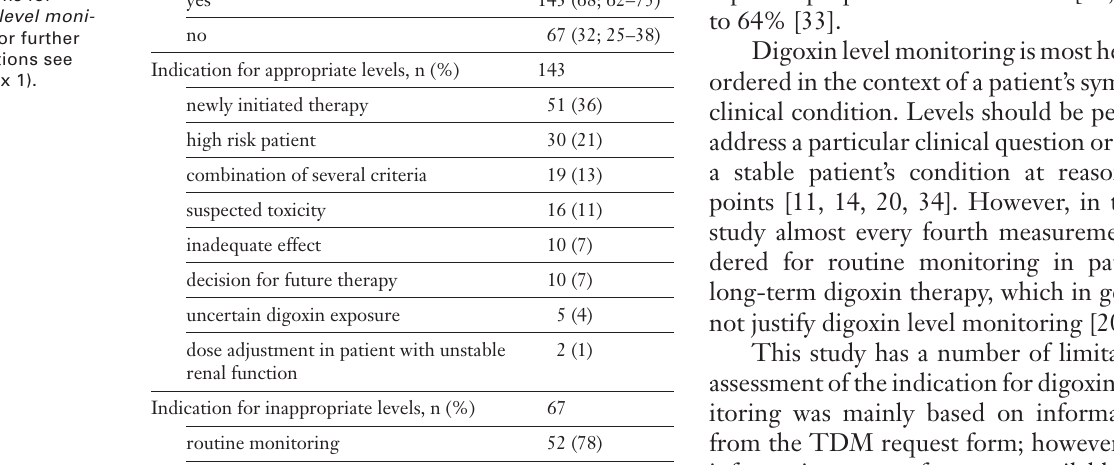
Table 3 Indications for digoxin level moni- toring (for further explanations see Appendix